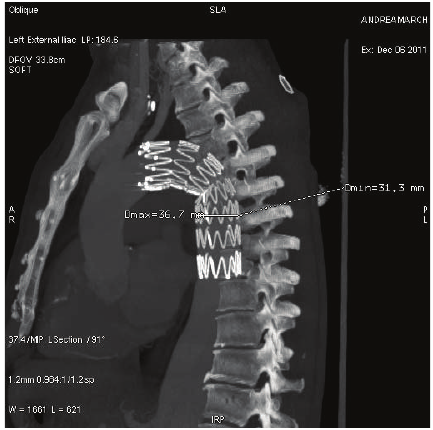
Figure 5: Six-month follow-up CTA reveals that stent-graft place- ment was